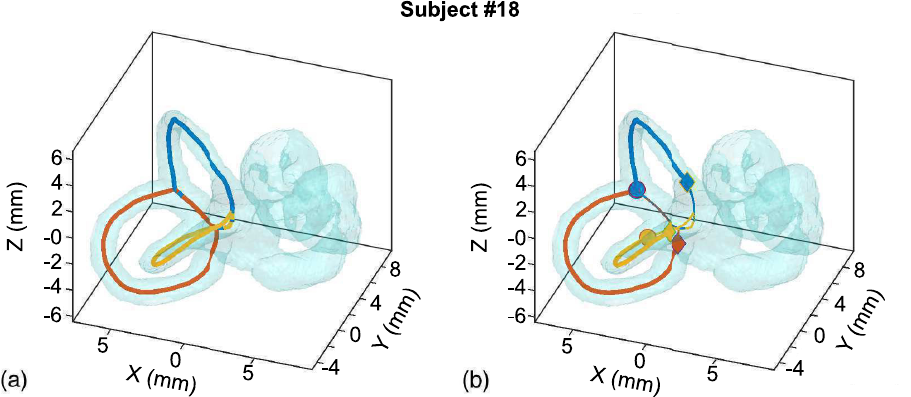
Figure 3. Transparent volume of volunteer S18 SCs. Inside the volume, each colored line represent the centerline of one duct: ( a ) the whole centerline is considered; and ( b ) the ampulla is excluded from the centerline. The sphere and diamonds correspond to the beginning and end of the retained trajectory (thick line) from the original centerline (thin line). The color encoding is yellow for the horizontal, blue for the anterior and red for the posterior